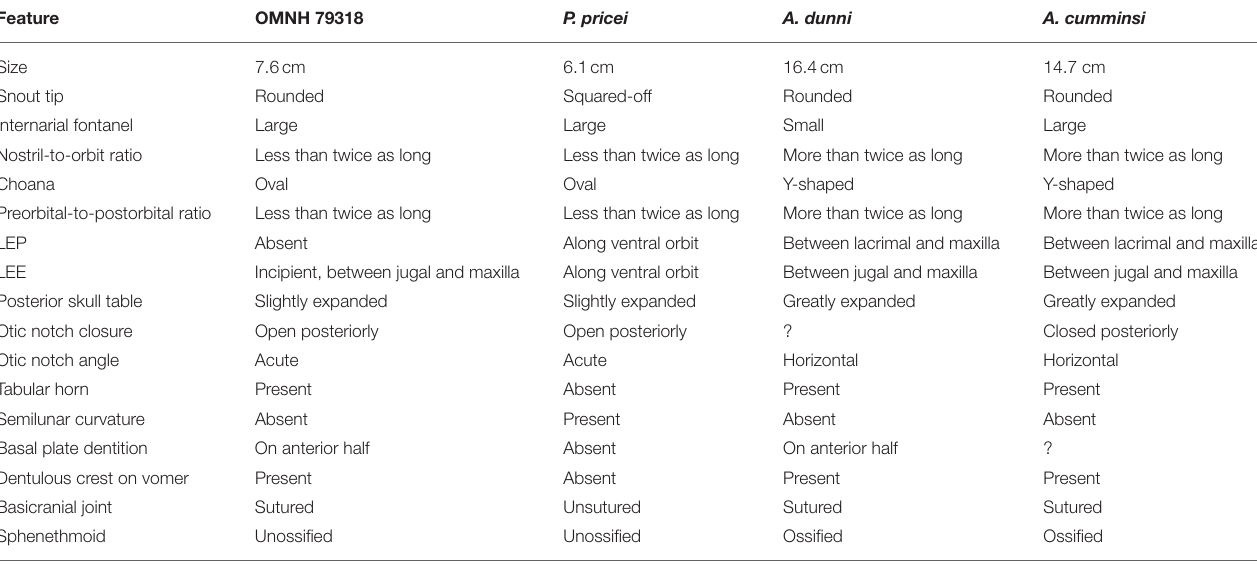
TABLE 1 | Summary table of differences between OMNH 79318, Phonerpeton pricei, Acheloma dunni, and Acheloma